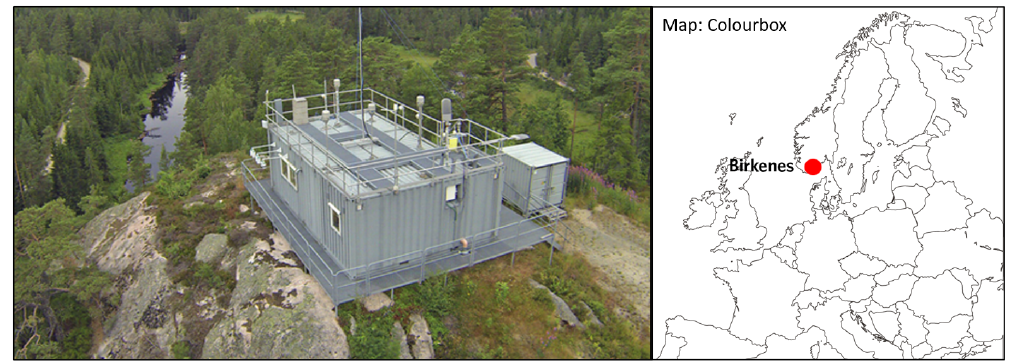
Figure 1. The Birkenes Observatory (58 ◦ 23 (cid:48) N, 8 ◦ 15 (cid:48) E; 219ma.s.l.) lies in the Boreo-nemoral zone, 20km from the Skagerrak coastline in southern